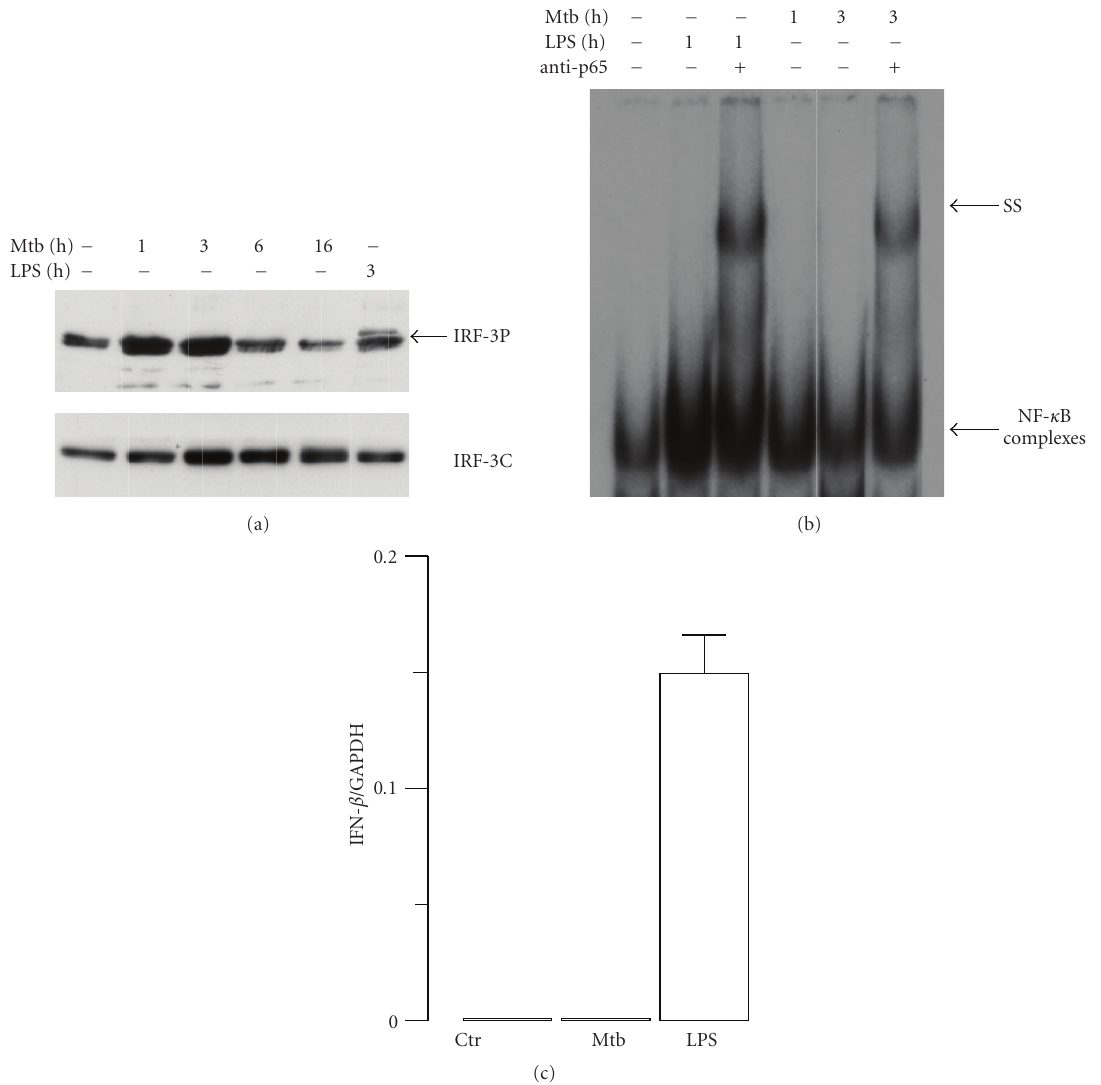
Figure 3: Analysis of IFN- β gene regulation in Mtb-infected or LPS-treated human monocytes. (a) Total cell extracts were prepared at di ff erent times following infection with Mtb or LPS treatment. Whole cell extracts (30 μ g) were analyzed on an SDS-7% PAGE gel and subjected to immunoblot analysis with anti-IRF-3 antibody to detect the phosphorylated IRF-3 isoform (IRF-3P; upper panel). The total content of IRF-3 was evaluated as an internal loading control (IRF-3C; lower panel). The results shown are from one of three experiments performed with cell extracts from di ff erent monocyte cultures that yielded similar results. (b) Nuclear extracts were prepared from Mtb- infected at di ff erent time points or from cells treated for 1hr with LPS. Five μ g of nuclear proteins were subjected to EMSA analysis using as oligonucleotide the κ B-IFN- β sequence. Supershift assays were performed after incubation with anti-p65 Abs as indicated (ss). (c) RNA was extracted from monocytes infected with Mtb (MOI = 1) or treated with LPS (1 μ g/ml) for 8 hr. Real-time reverse transcription-polymerase chain reaction was performed to measure the expression of IFN- β . The results are shown as a ratio to the GAPDH level and represent the mean ± SE of triplicate values. The results shown are from one out of three experiments performed with di ff erent donors that yielded similar